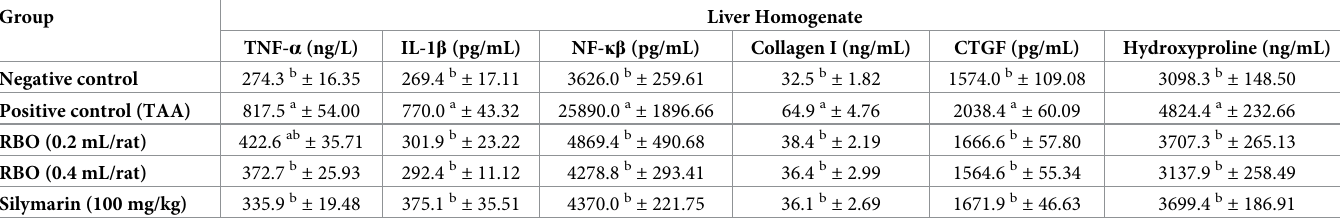
Table 3. Impact on inflammatory mediators (TNF-, IL-1, NF- κβ , collagen I, CTGF and hydroxyproline) in liver tissue. Group Liver